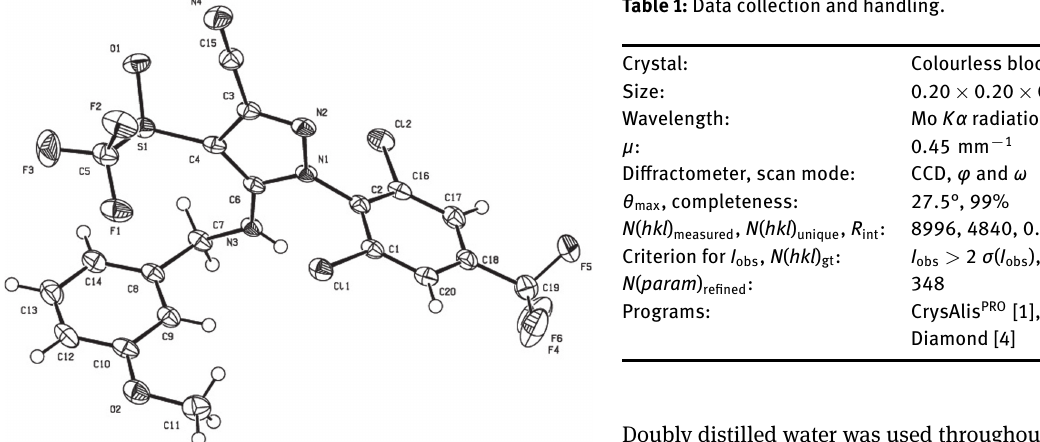
Table 1: Data collection and